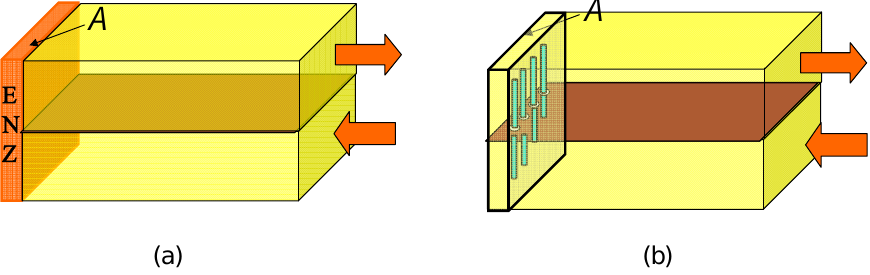
Figure 1. Different waveguide geometries that support electromagnetic energy tunneling. ( a ) Two short-circuited waveguides connected by a thin layer of epsilon-near-zero material; and ( b ) the two waveguides connected with a cylindrical wire